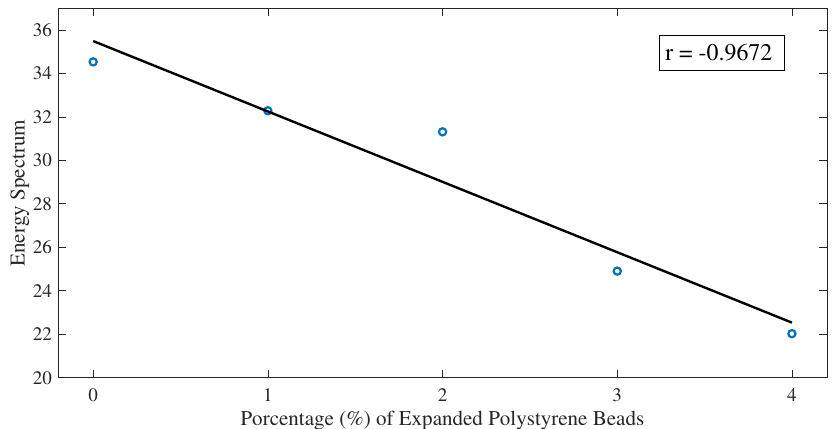
Figure 9. Fundamental harmonic amplitude averages over the window of the CFST samples using the STFT algorithm. The solid black line is a linear fit of the data. Pearson correlation coefficient r = − 0.9672.